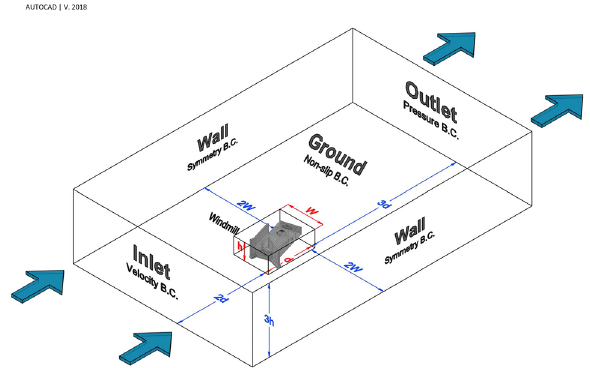
Figure 5. Domain dimensions and boundary conditions.